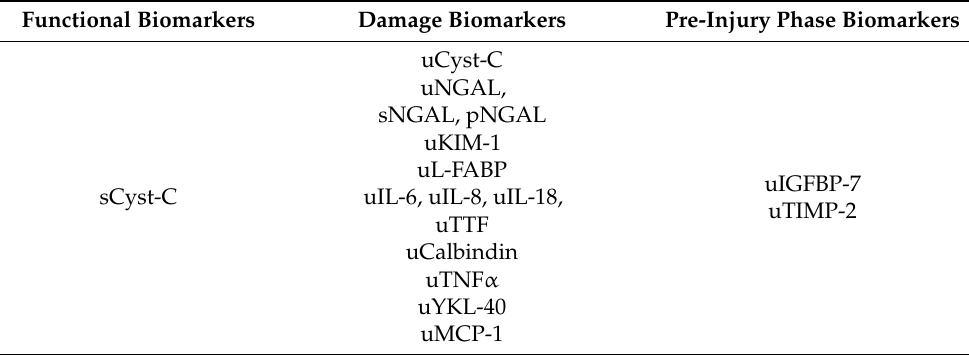
Biomarkers of acute kidney injury (AKI) studied in exercise discussed in this review—classification according to Oh et al.